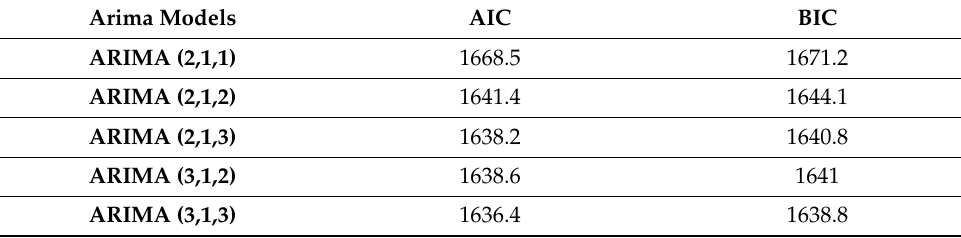
Figure 11. Autocorrelation function curves (ACF) of first order differenced time-series ( a ) U g ( b ) α g ( c ) U d ( d ) α d .